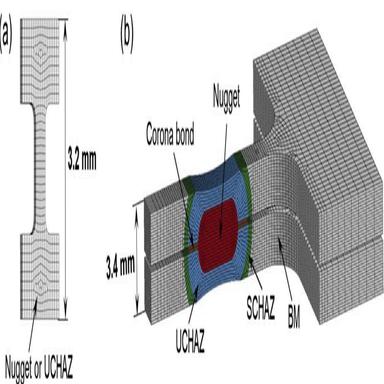
Finite element models of the mechanical tests of weld zones. (a) Miniature tensile test of nugget and UCHAZ; (b) mini-peel test.